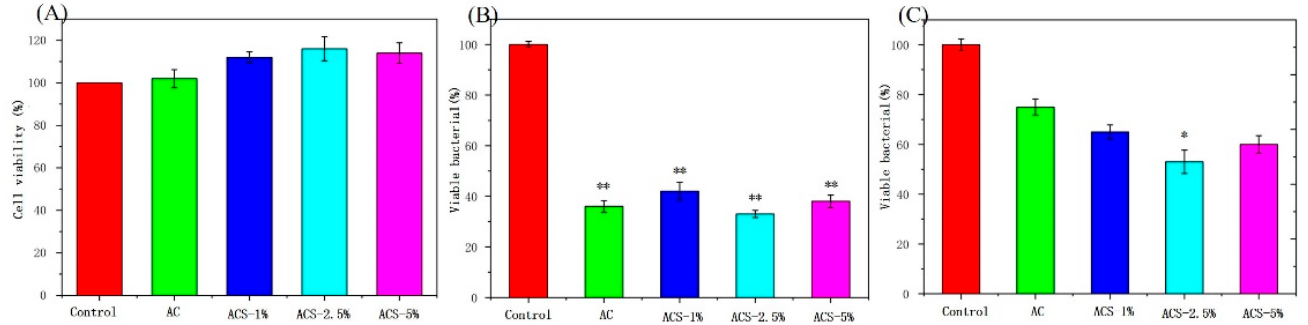
Figure 5. ( A ) Cytotoxicity testing. ( B ) Survival of Staphylococcus aureus after contact with different sponges for 24 h. ( C ) Survival of Escherichia coli after contact with different sponges for 24 h. Data are the mean ± SD for each group ( n = 3), * Significant difference from the control group, * p < 0.05, ** p <